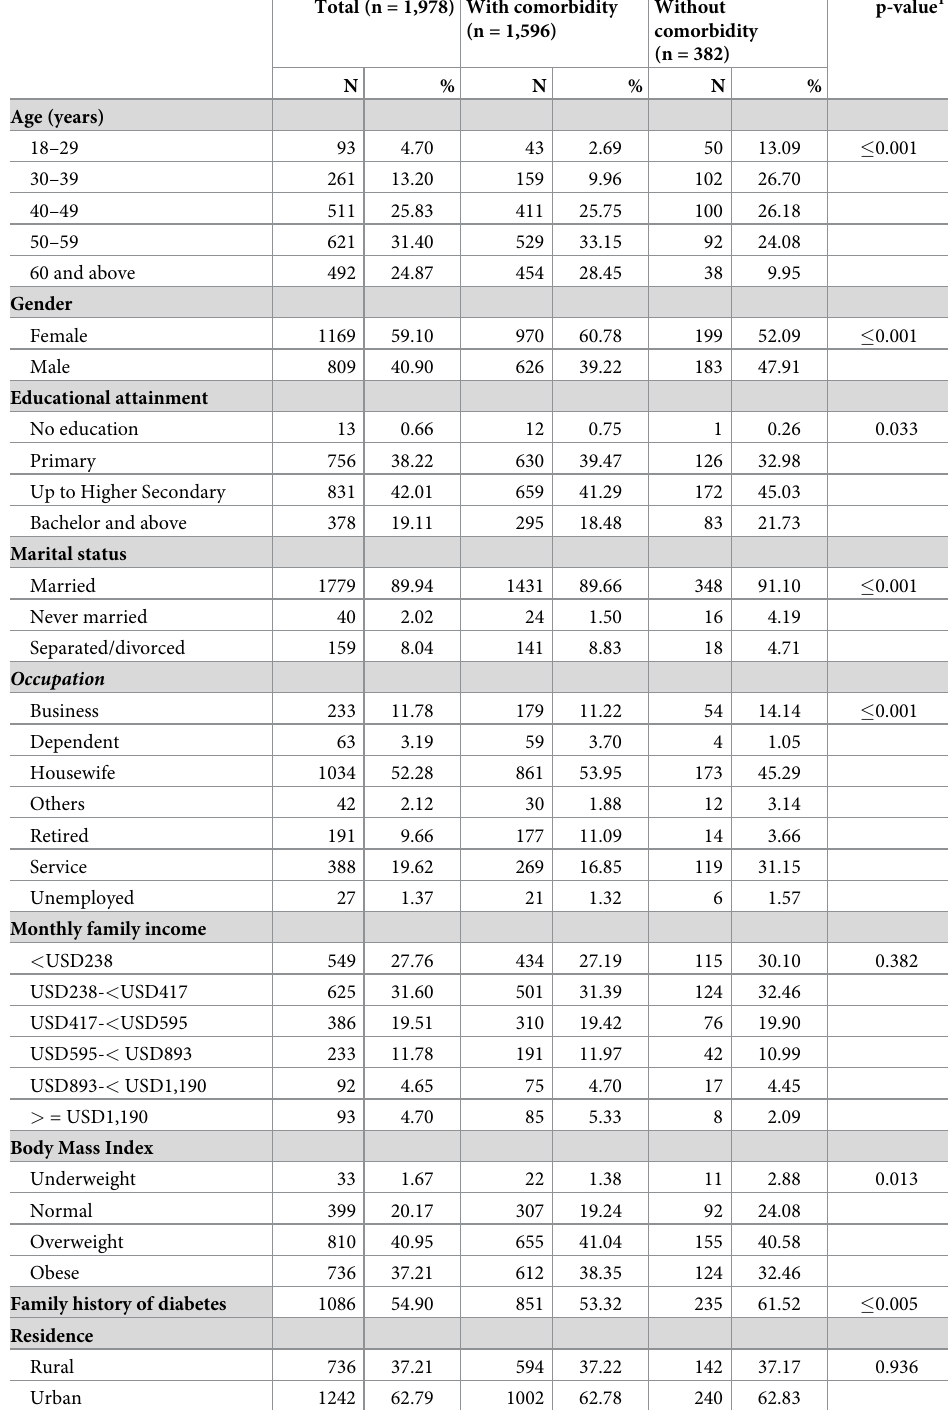
Table 1. Characteristics of study patients suffering from